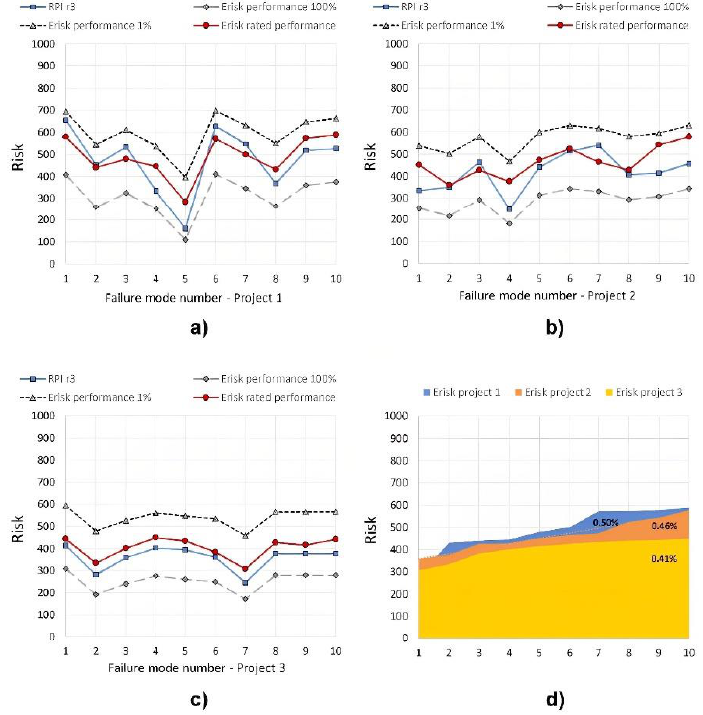
Figure 8. Case 1, risk results considering the weights QMI 0.3, Severity 0.3, Occurrence 0.2, Detectability 0.2 ( a ) project 1 results, ( b ) project 2 results, ( c ) project 3 results, ( d ) effective risk for projects 1, 2, and 3 considering the weights of Case 1.